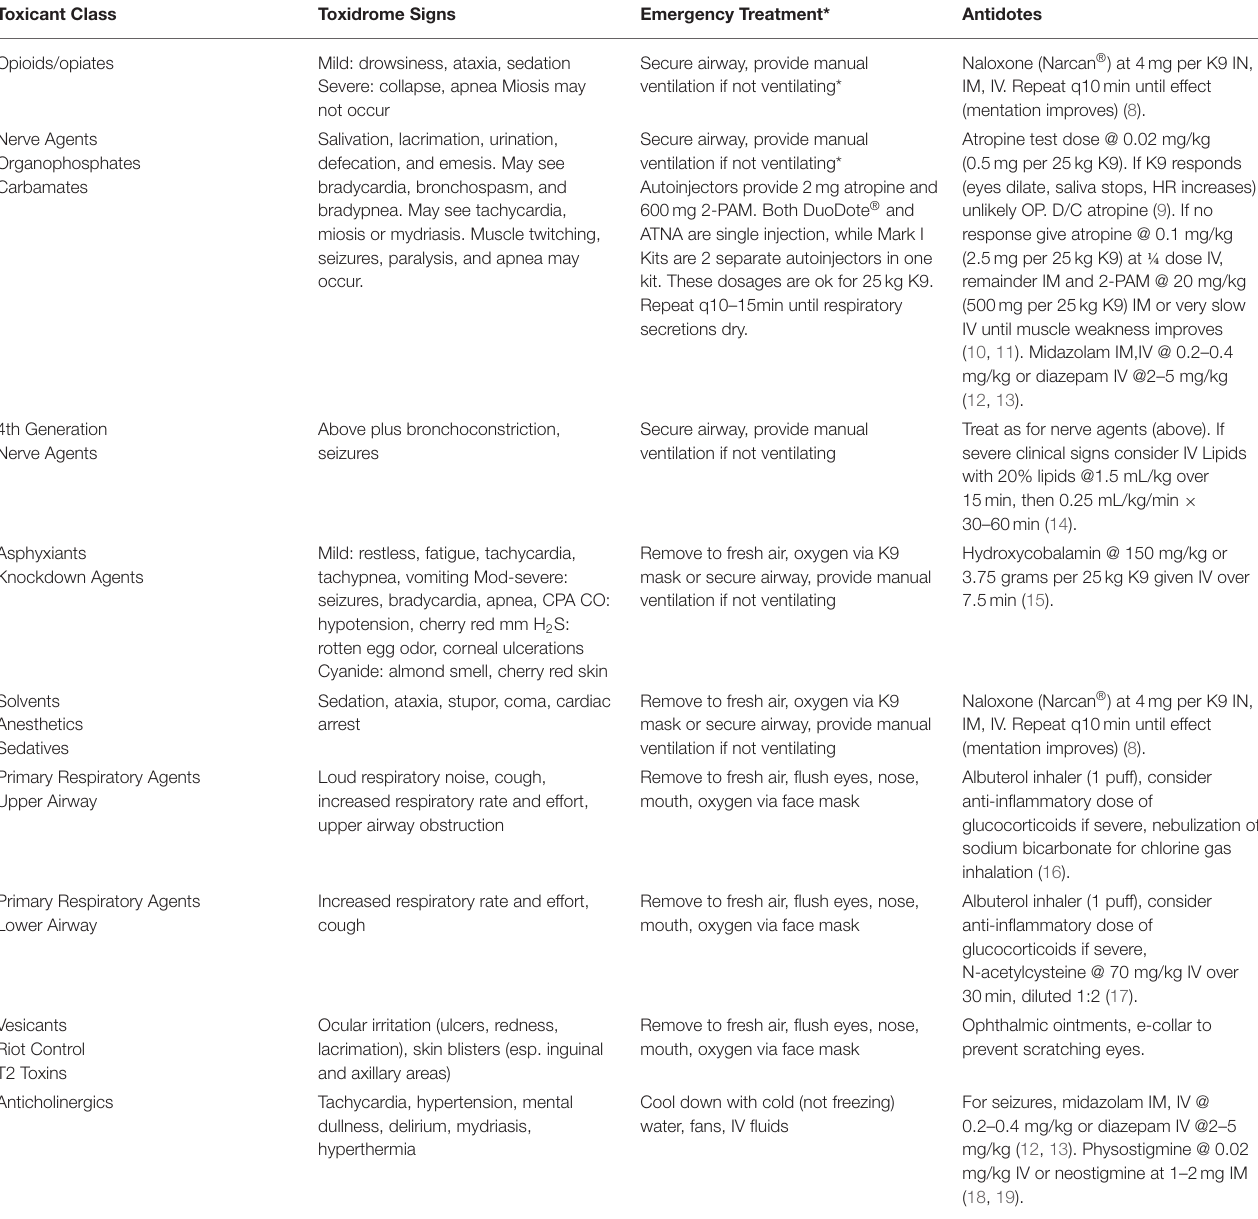
TABLE 2 | Emergency